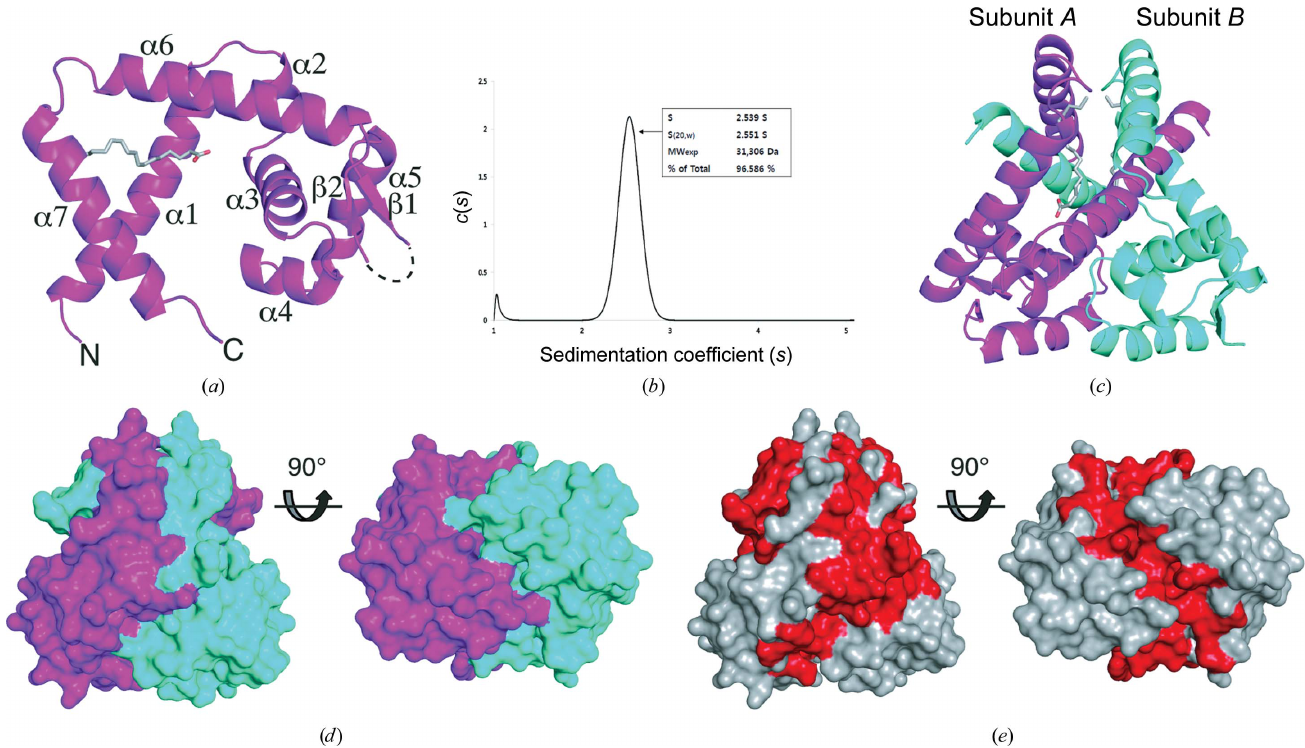
Figure 1 Overall structure of Pa MarR. ( a ) Monomeric structure of Pa MarR. The structure in the asymmetric unit is represented as a cartoon and the sticks indicate palmitic acid. ( b ) Analytical ultracentrifugation profile of Pa MarR. Data are plotted as sedimentation coefficient ( x axis) and its distribution ( y axis). ( c ) Dimeric structure of Pa MarR. Subunit B originates from a crystallographic neighbouring molecule. ( d ) Surface representation of Pa MarR. The dimeric structure is viewed from two different directions. The colour code is the same as in ( c ). ( e ) Interactions between two subunits of Pa MarR. Interface regions are coloured